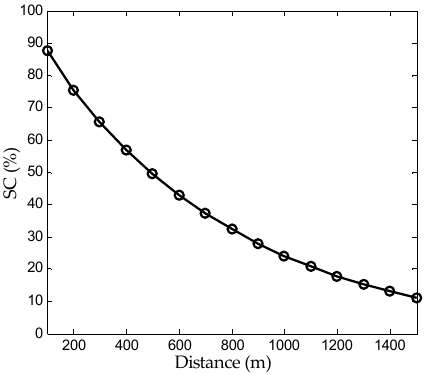
Figure 18. The relationship between the broken point distance and parameter SC .